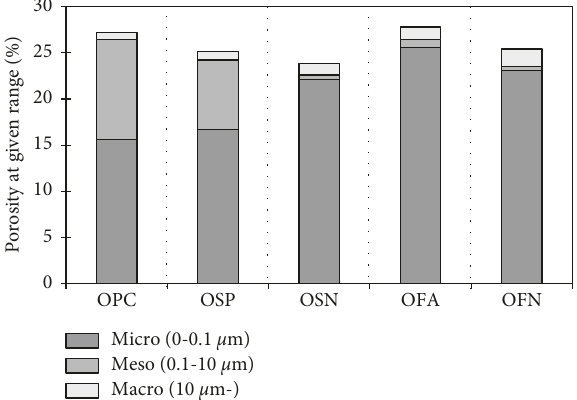
Figure 3: Mercury intruded volume at a given porosity for samples with different mix proportions cured for